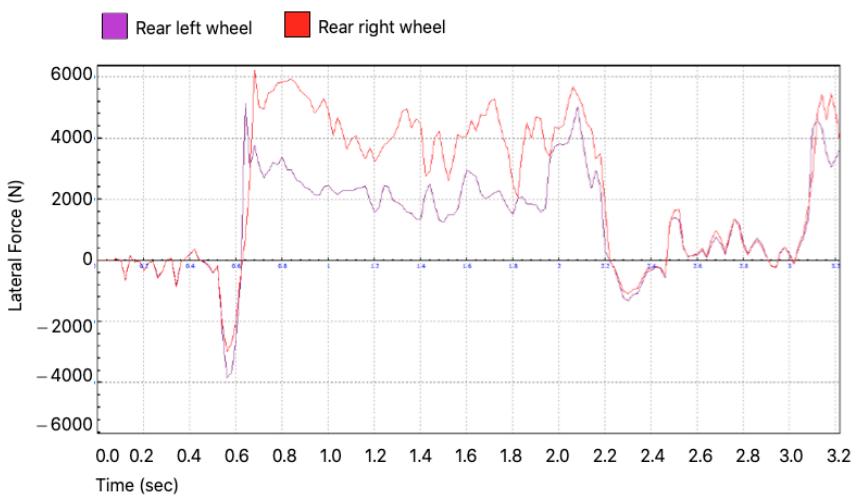
Figure 12. Resistance to total friction in the two rear wheels of the bogie in a conventional turnout. Green and blue are used for the left and right front wheels (Figure 11), and purple and red are used for the left and right rear wheels (Figure 12), respectively. Another relevant factor in this plot is the 300 m radius of the turnout, as well as the common crossing length of 3.5 m and the speed of 60 km/h. The progress of the bogie, represented by the lateral force of friction on the wheels, may also be observed.